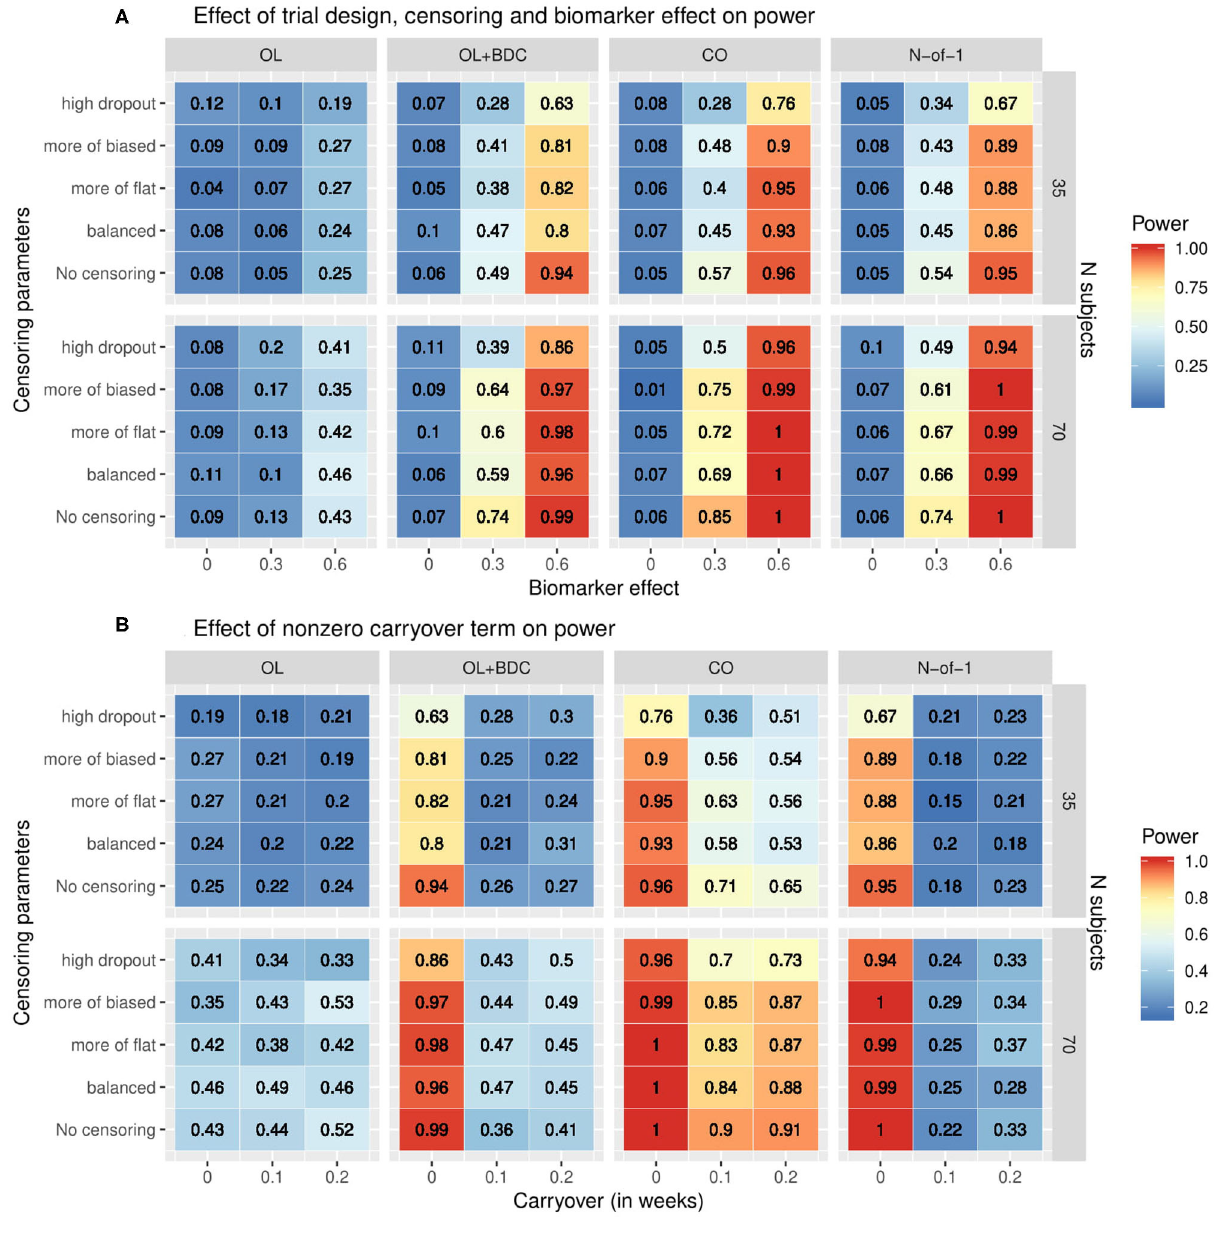
( Figure 5B ). Consistent with expectation, increased maximal response of the BR factor improved power across all trial